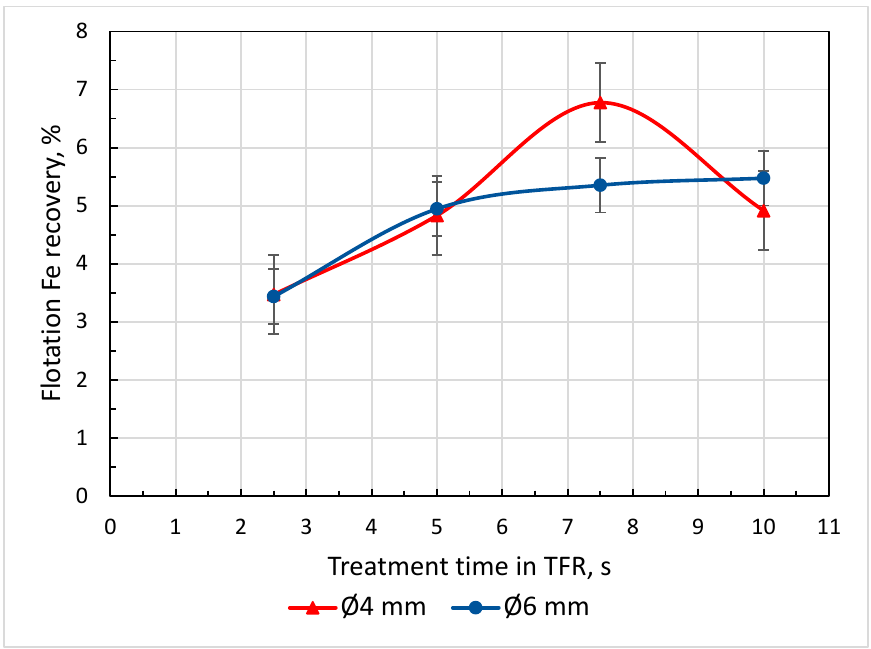
Figure 11. Dependence of the share of the flotation recovery of iron in tailings (froth product) on the treatment time in TFRs having 4 and 6 mm inner diameters. CTAB dosage—20 g/t, fine bubbles dosage—0.21 mL/g.